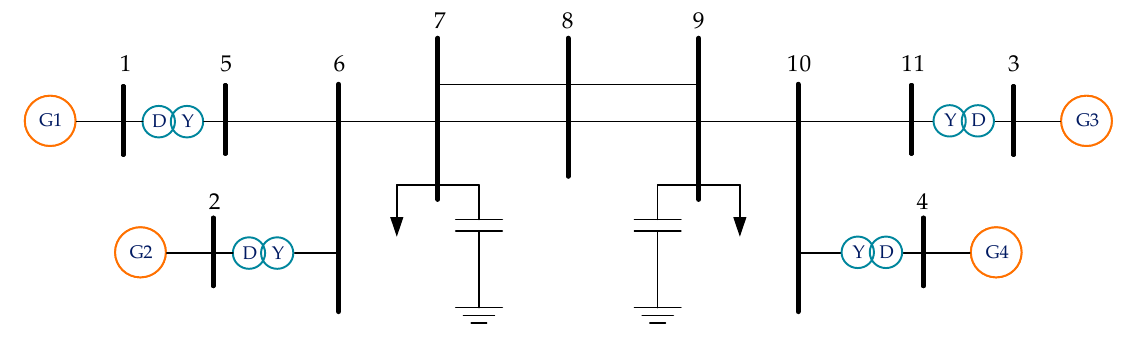
Figure 9. Kundur’s two-area system topology.